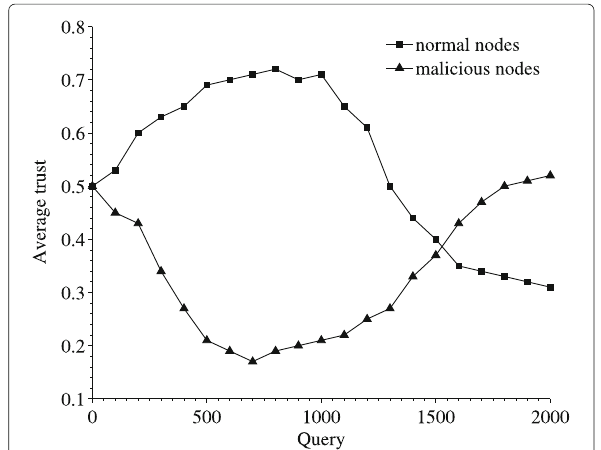
to about 75% / 77.5% compromised nodes in the net- work) when the average trust values of both kinds of nodes reach the same point. After that, the average trust value of compromised nodes exceeds that of the legitimate nodes, which makes the whole network compromised and